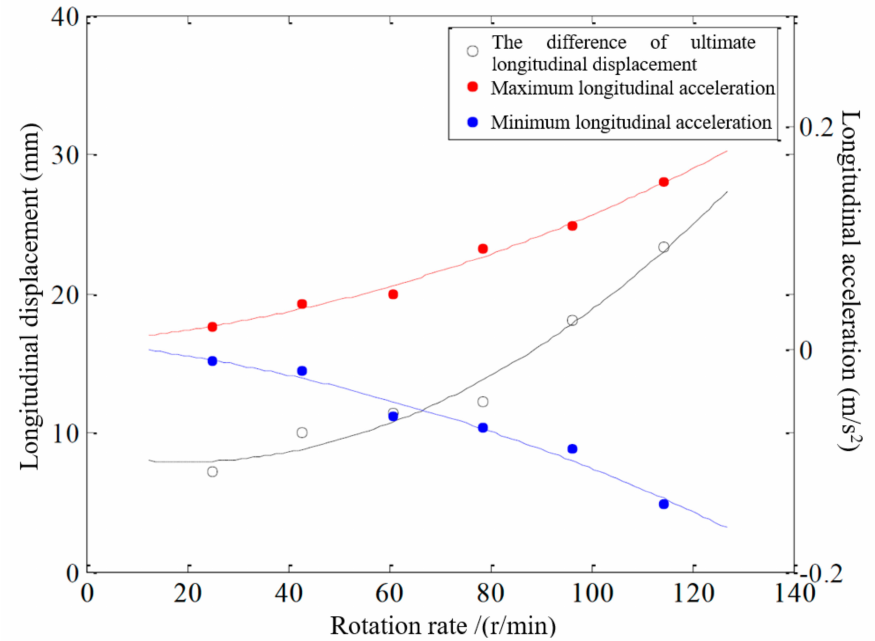
Figure 13. The variation of longitudinal motion amplitude and ultimate acceleration of drill string with rotation